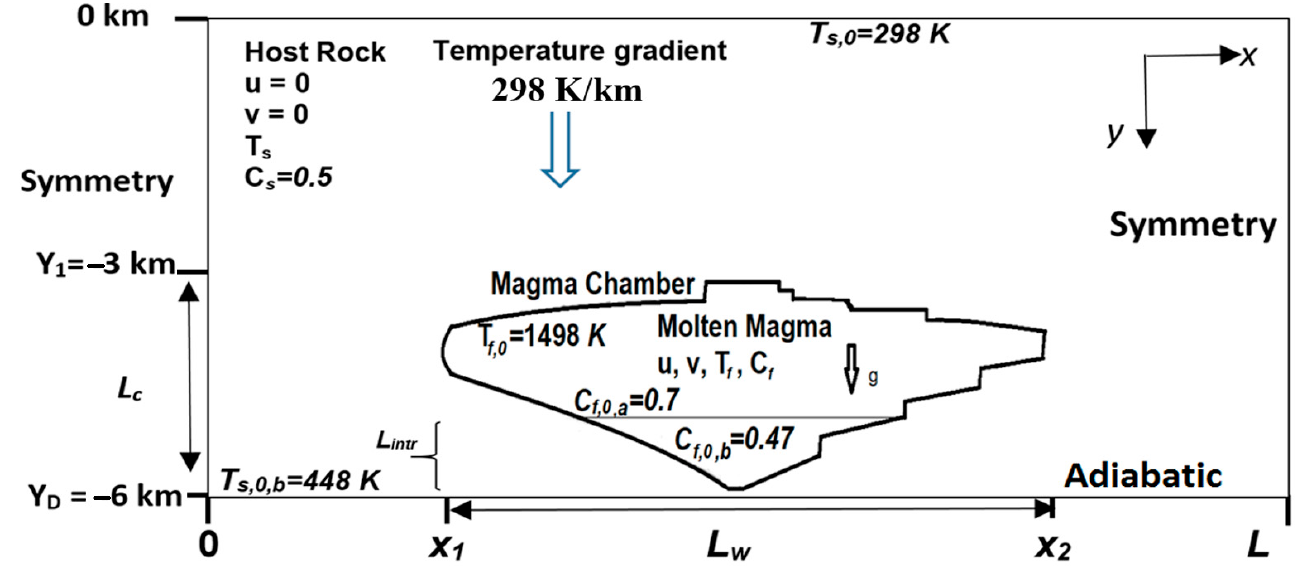
Figure 1. Cross ‐ section of a quasi ‐ elliptical magma chamber (case 3) surrounded by a host rock approximately representing emplacement of the Humay unit in the PCB. This pluton form is a combination of the cantilever and piston mechanisms [21].